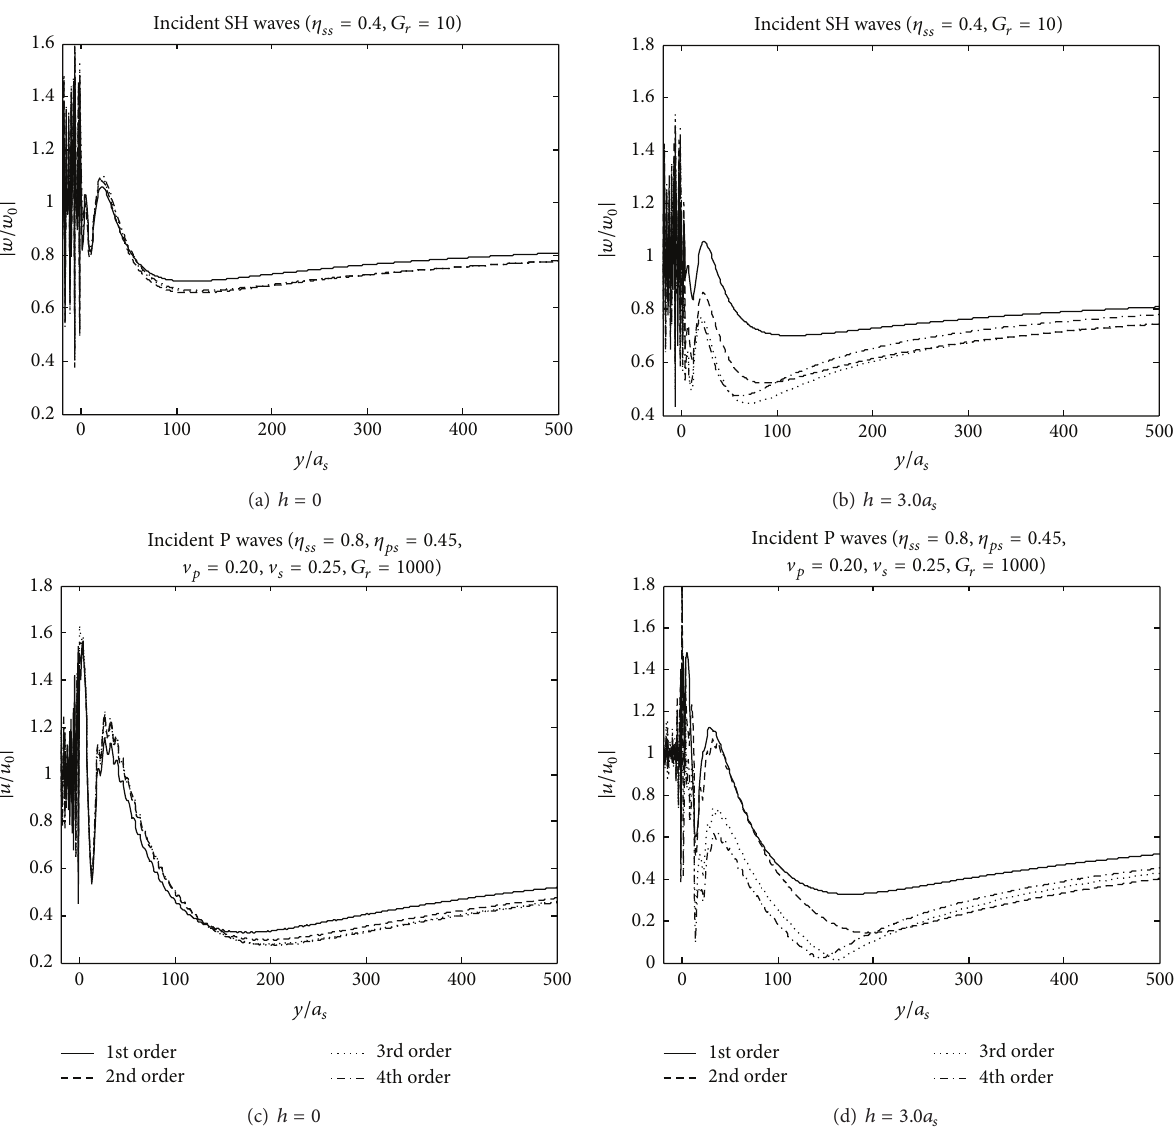
Figure 3: Normalized displacement amplitudes curves along midline behind the isolation system under different scattering orders by rows of tubular piles ( 𝑠 𝑝 ,= 3.0𝑎 𝑠 , 𝑏 𝑠 = 0.9𝑎 𝑠 , 1 ≤ 𝑚 ≤ 4 , 𝑁 = 8